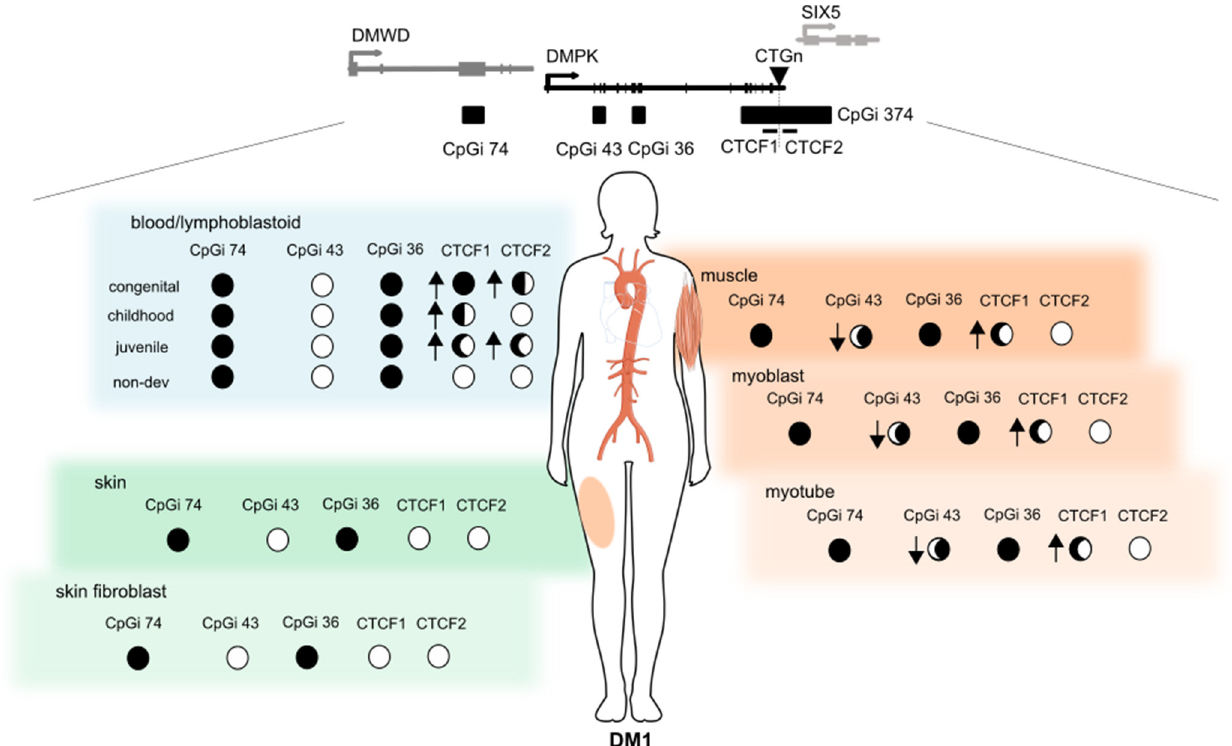
Figure 6. Summary of the epigenetic landscape of the DMPK locus in DM1. An overview is given of the methylation status across the DMPK locus in muscle, skin and blood and their derived cells in DM1 patients. The circle underneath each CpG island represents its methylation status, ranging from fully methylated (black) to completely unmethylated (white) in DM1 patients. The arrows indicate the changes compared to controls, where an upward arrow means increased methylation in DM1 compared to controls. This figure was partially made using Servier Medical Art (smart.servier.com, accessed on 31 March 2022).